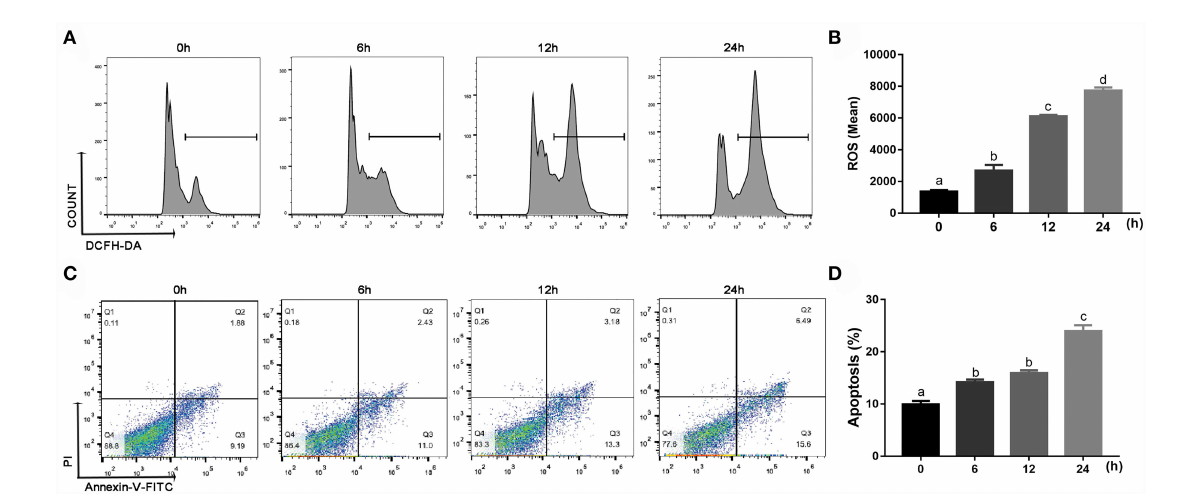
FIGURE5 Effects of β -Hydroxybutyrate (BHB) on reactive oxygen species (ROS) content and apoptosis of CD14 + monocytes. Monocytes were treated with 3.0 m M of BHB for 0, 6, 12 or 24h. (A,B) ROS content in monocytes. (C,D) Apoptosis of monocytes. Comparisons among groups were calculated using a one-way ANOVA with subsequent Bonferroni correction. Data are means ± SEM of three independent experiments. Different lowercase letters in the bar chart indicate significant differences ( P < 0.05).